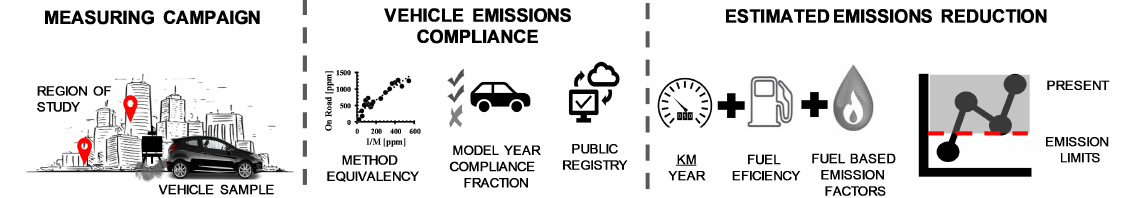
Figure 1. Illustration of the proposed methodology to estimate the percentage of reduction of tailpipe emissions that could be obtained by implementing an I/M